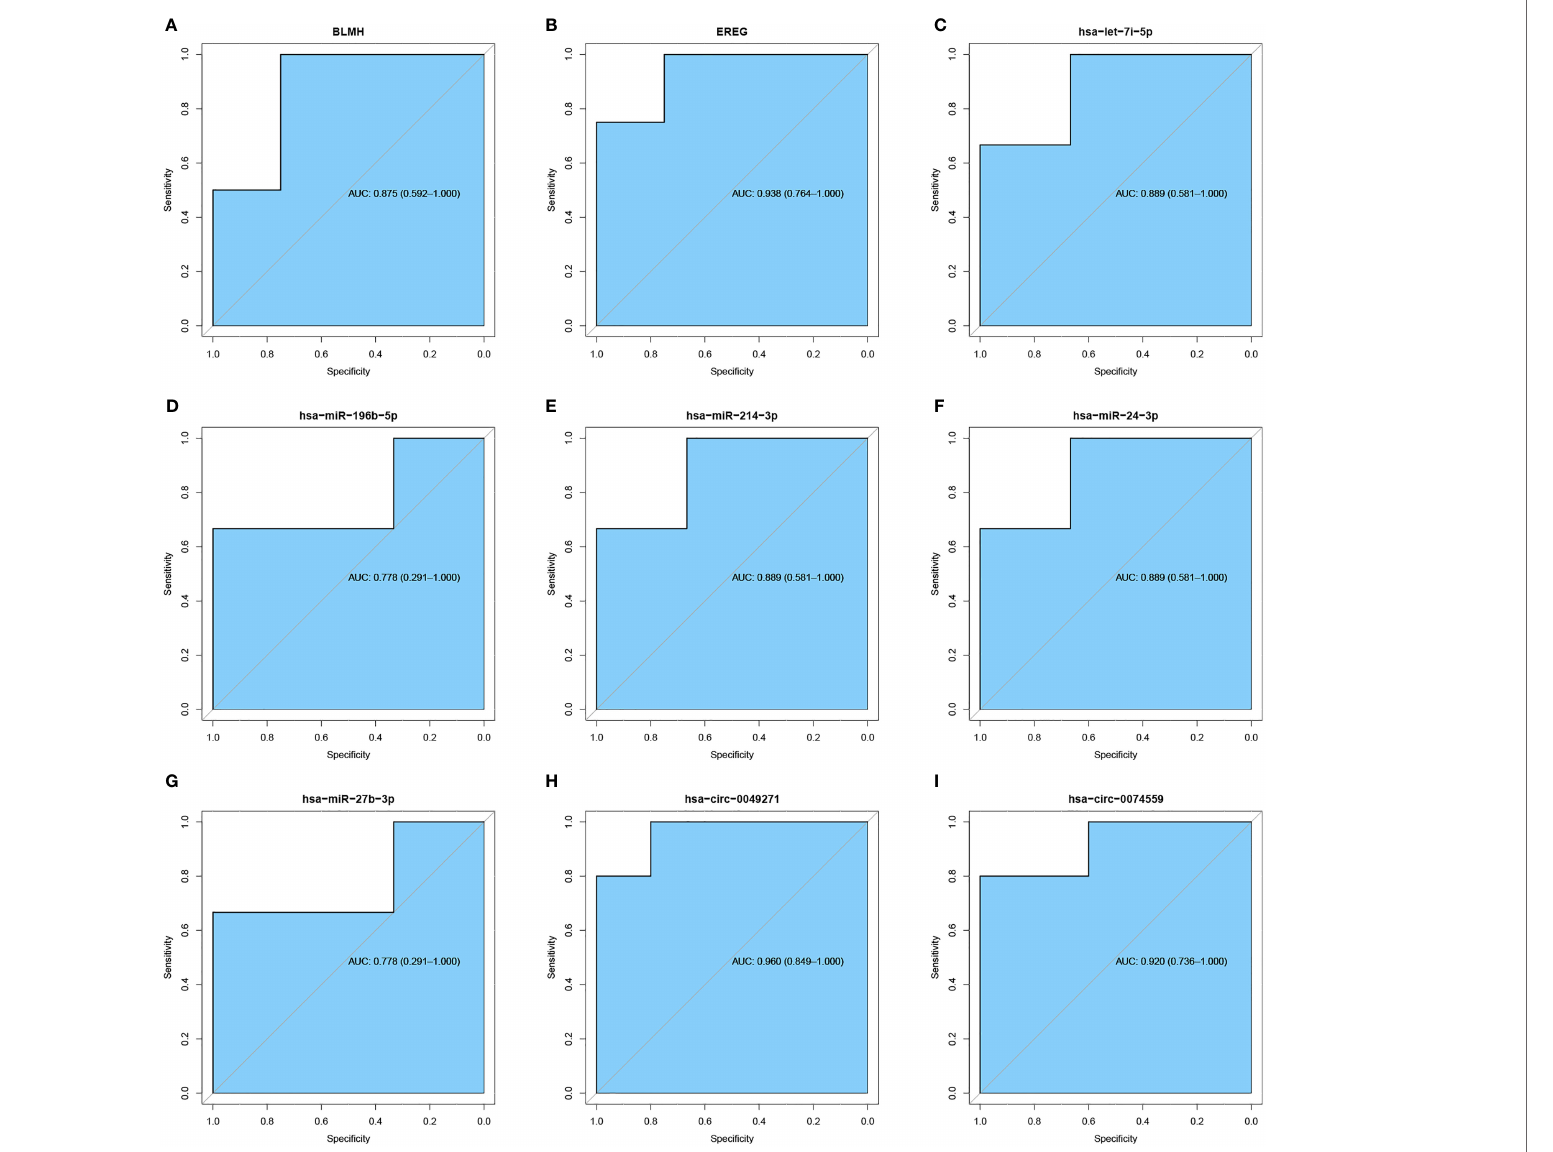
FIGURE 9 | ROC curve of signi fi cant mRNA, miRNA, and circRNA. (A, B) ROC curve of signi fi cant mRNA. (C – G) ROC curve of signi fi cant miRNA. (H, I) ROC curve of signi fi cant circRNA. The blue areas represent